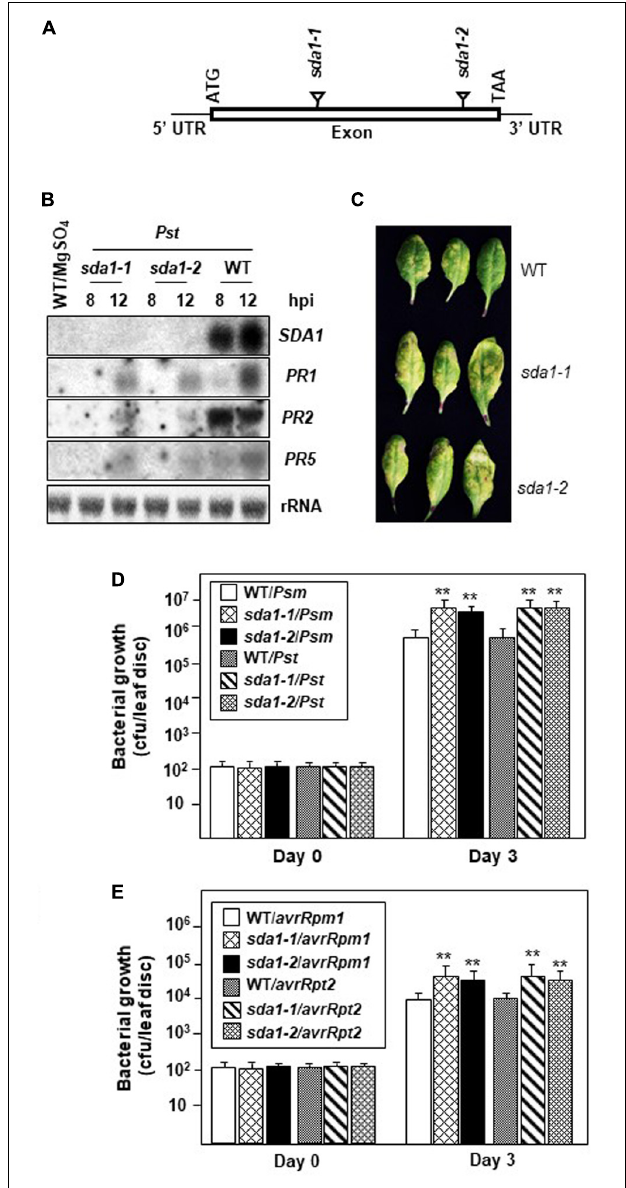
FIGURE 2 | PR gene expression and resistance against bacterial pathogen is compromised in sda1 mutants. (A) Diagram depicting site of insertion of T-DNA in sda1-1 and sda1-2 mutants. The Rectangle indicates exon and black lines indicate 5’ and 3’ UTRs. (B) Total RNA was isolated from the leaves of 4-week-old plants of indicated genotypes inoculated with virulent bacterial pathogen Pst DC3000 ( Pst ) at a titer of 5 × 10 7 cfu/mL in 10 mM MgSO 4 . Tissue samples were harvested at indicated hpi. Transcript levels were determined by RNA gel-blot analysis. Blots were stained with methylene blue to show the relative amounts of RNA in each lane (28S rRNA). Blots were probed with SDA1 gene probe, stripped and re-probed with PR gene probes as indicated. (C) Rosette leaves of 4-week-old plants of indicated genotypes were inoculated with Pst DC3000 at a titer of 5 × 10 5 cfu/mL and leaves were photographed at 3 dpi (days post-inoculation). (D,E) Rosette leaves of 4-week-old plants of the indicated genotypes were inoculated with indicated pathogen at a titer of 5 × 10 5 cfu/mL. Eight plants for each genotype were analyzed individually. Data are reported as mean bacterial count (cfu per